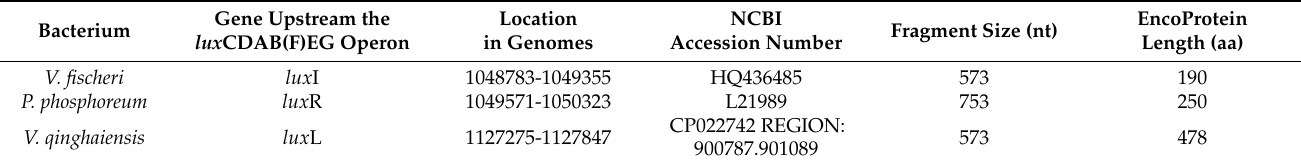
Table 1. Comparison of the gene associated with luminescence in three species. Gene Upstream the Bacterium lux CDAB(F)EG